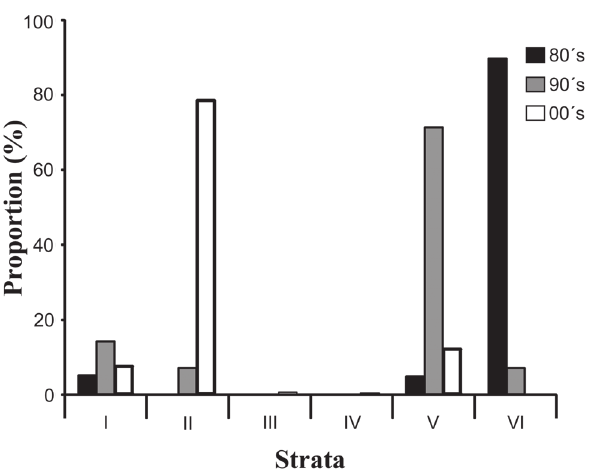
Fig.2. Proportion of individuals recorded in each stratum during bottom trawl surveys. Surveys carried out in the 1980´s: REDE 1986 and Gallo 1986; surveys carried out in the 1990´s: REDE 1995 and 1996; surveys carried out in the 2000´s: REDEs 2004 to